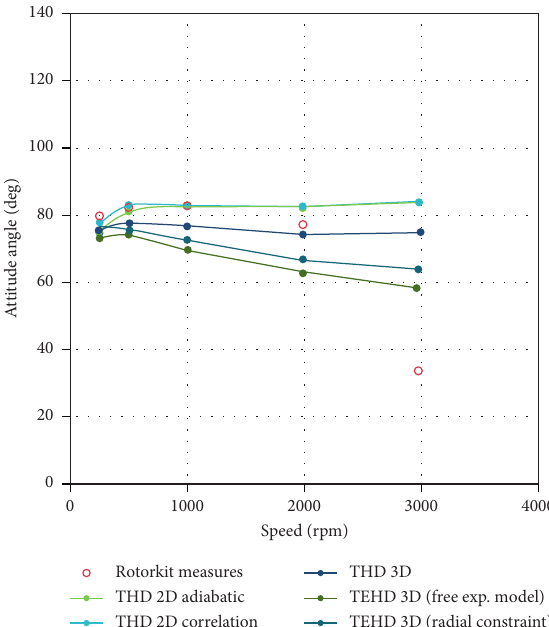
Figure 19: Attitude angle plot for the modified RK with respect to 3D numerical THD and TEHD simulation results in configuration 2.